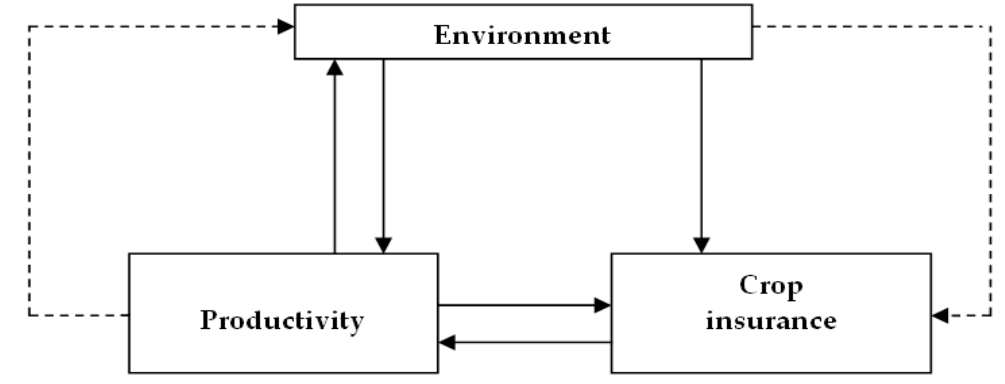
Figure 1. Crop insurance, productivity and the environment—a conceptual model. This study focuses on the relationship between crop insurance and the level of land productivity, considering the simultaneity and interdependence of decisions about the level of insurance and the intensity of use of the productive resource, which is land, and their environmental impact. As the agricultural sector implements measures to adapt to or deal with climate variability and change, the potential negative consequences of these measures should be explored to avoid increased sensitivity or (unintended) environmental impacts [20]. In this context, we contribute to the international literature that tries to identify and assess the environmental consequences of